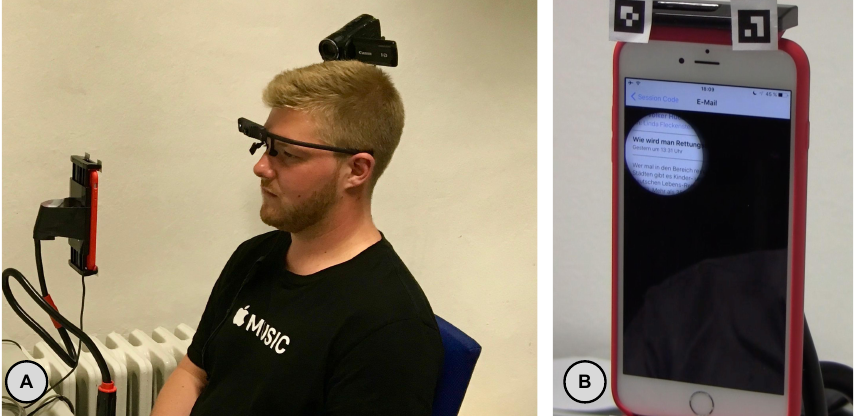
Figure 2. The figure shows the usability study’s setup. The iPhone was mounted on a holder such that it was 30 cm away from the user’s eyes ( A ). From the user’s perspective, they could see the phone with the spot moving according to the user’s gaze ( B